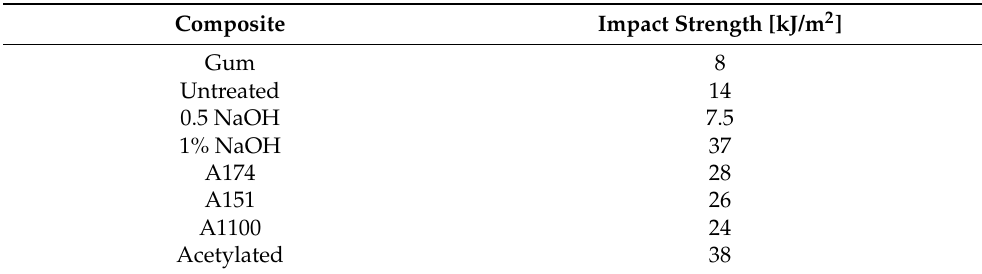
Table 6. Influence on the impact strength of untreated and different chemical-treated banana fibre- reinforced polyester composite [113].